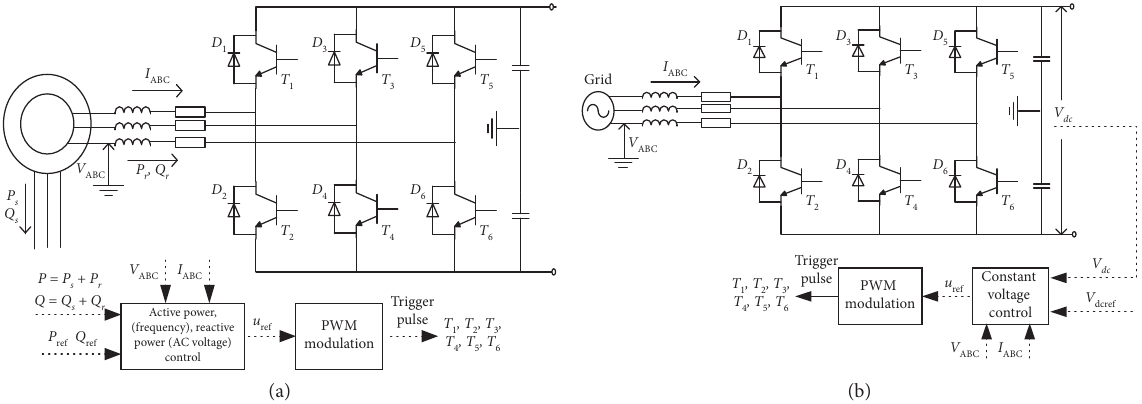
Figure 2: Topology structure and control method of the converter. (a) Topology structure and control method of the machine-side converter. (b) Topology structure and control method of the grid-side converter.